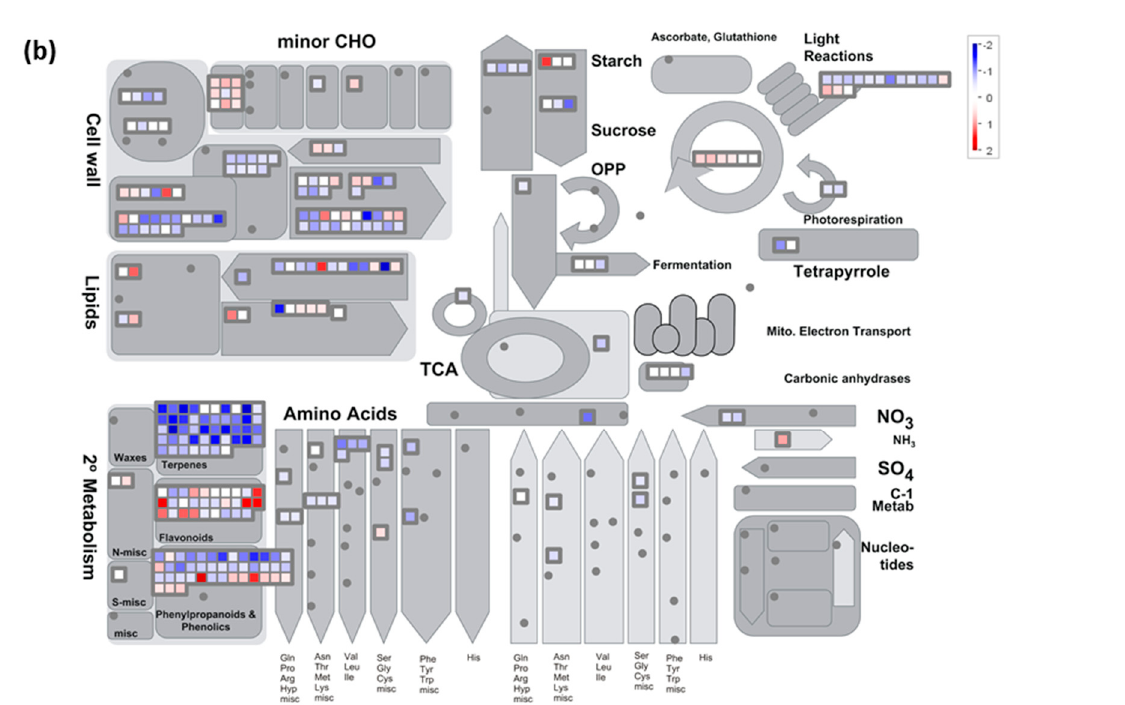
Figure 5. Mapman visualization of the metabolism overview pathway modulation at ( a ) 8 h and ( b ) 2 h